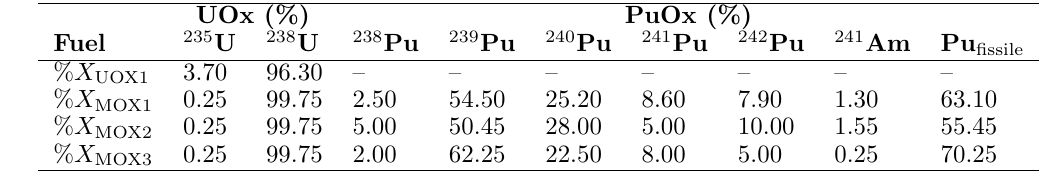
Table 6. Isotopic compositions studied for UOx and MOx assemblies characterization. UOx (%)